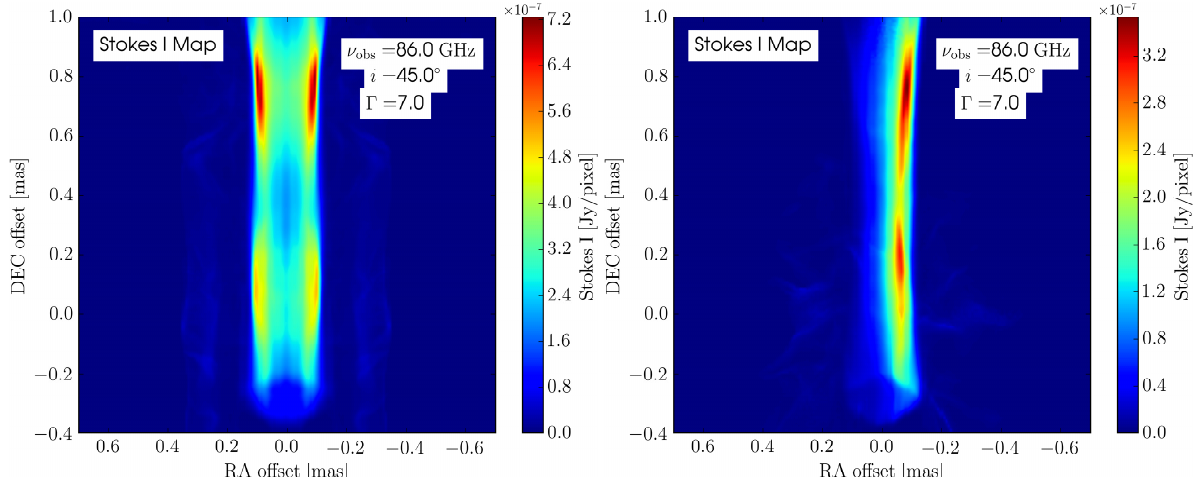
Figure 10. RMHD computations of limb brightening produced by the presence of a toroidal B -field component for the case of a purely toroidal field ( left ) and a helical field with an appreciable poloidal component ( right ), for a jet viewing angle of 45 ◦ . Images provided by Joanna